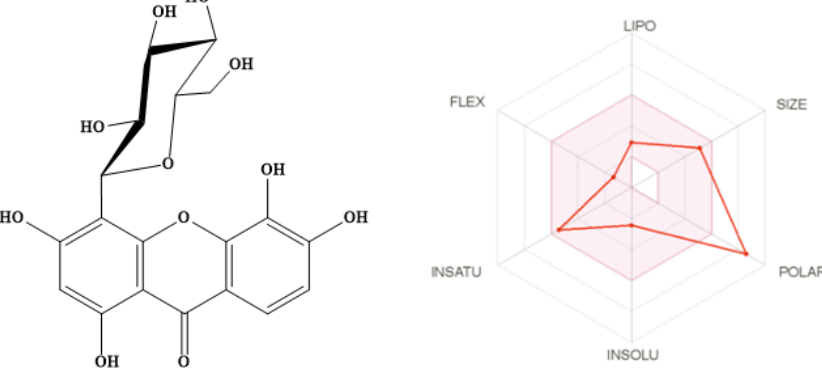
Figure 2. SwissADME plot of drug-likeness of isolated compound. The pink area represents the optimal range for each property (lipophilicity: XLOGP3 between − 0.7 and +5.0, size: MW between 150 and 500 g/mol, polarity: TPSA between 20 and 130Å 2 , solubility: log S not higher than 6, ration: fraction of carbons in the sp3 hybridization not less than 0.25, and flexibility: no more than 9 rotatable bonds. Table 2. Summary of SwissADME predicted physicochemical descriptors and ADMET parameter of the isolated compound.